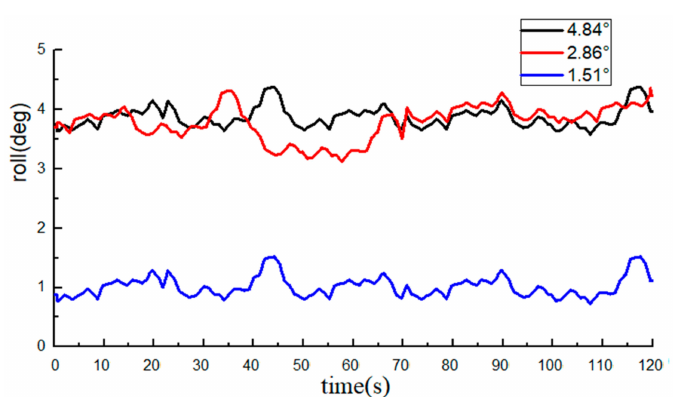
Figure 12. Data from the BDS (roll angle data are all negative).